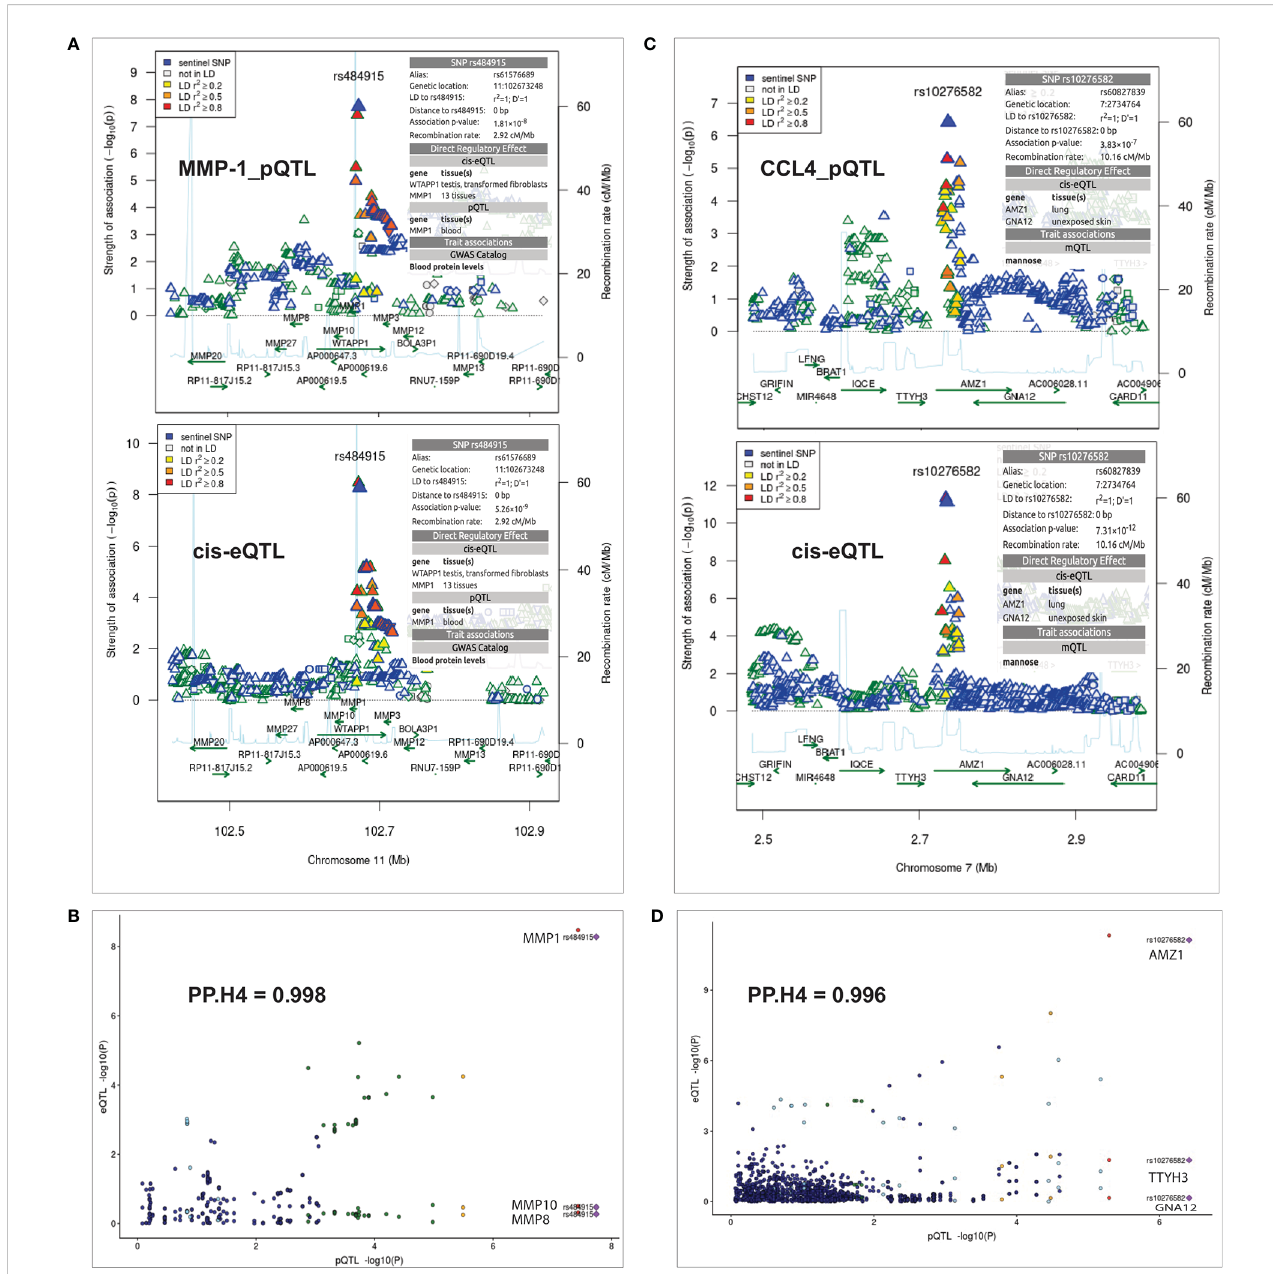
FIGURE 3 Summary of colocalization analyses between pQTL and eQTL. (A) Regional association plots at the MMP-1 locus for MMP-1 protein QTL result (top panel) and cis-QTL expressions result (bottom panel) on chromosome 11. (C) Regional association plots at the AMZ1 locus with CCL4 protein QTL result (top panel) and cis-QTL expressions result (bottom panel) on chromosome 7. The sentinel SNPs (rs484915 and rs10276582) are indicated with blue diamond shape and other surrounding SNPs are colored with different levels of linkage disequilibrium with the sentinel SNPs. The horizontal axis indicates chromosomal positions (NCBI human genome build 37) and the vertical axes represent negative log 10 p-values and recombination rates (cM/ Mb) estimated from 1000 Genome Project (European population) version 3.3. (B, D) Correlation plots with strong evidence of colocalization between pQTLs and eQTLs as indicated by PP.H4 (posterior probability of shared causal variants)